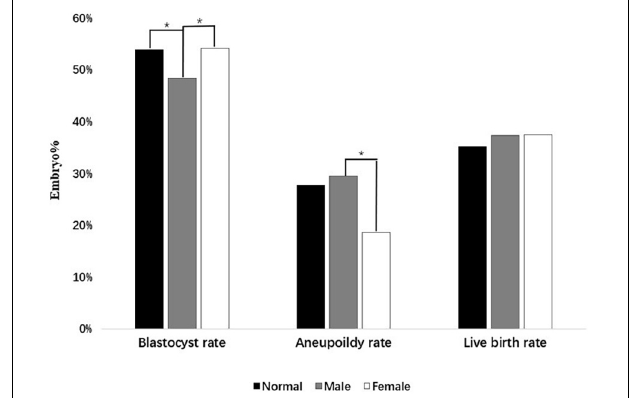
FIGURE 1 | The embryo quality between three groups. The difference in Blastocyst rate, Aneuploidy rate, and Live birth rate are shown in this figure. The symbol “ ∗ ” indicates a significant statistical difference ( p <